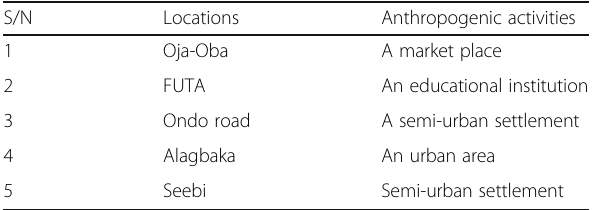
Table 1 Anthropogenic activities in the Akure South Local Government Area